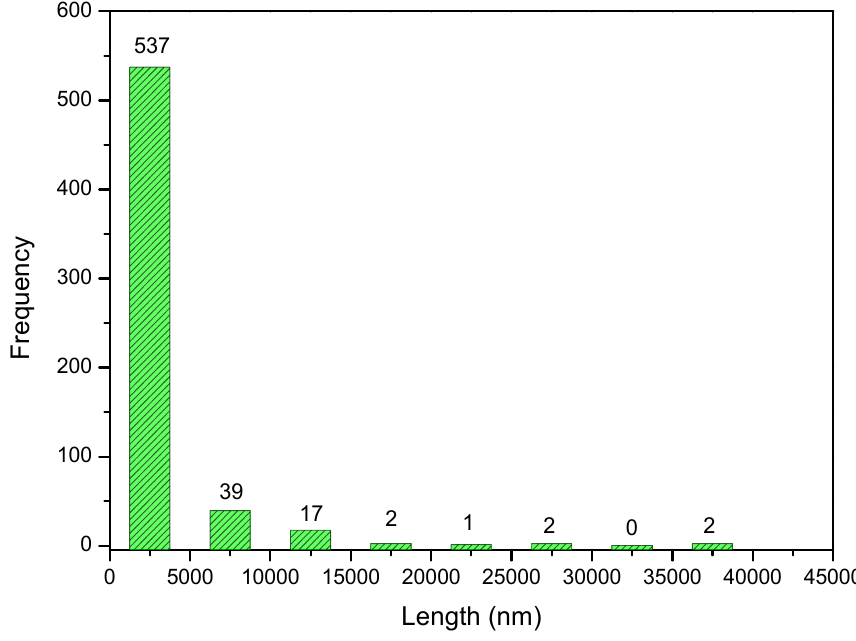
Figure 11. Frequency of distribution of pore size of Ce-HApCG biocomposite.